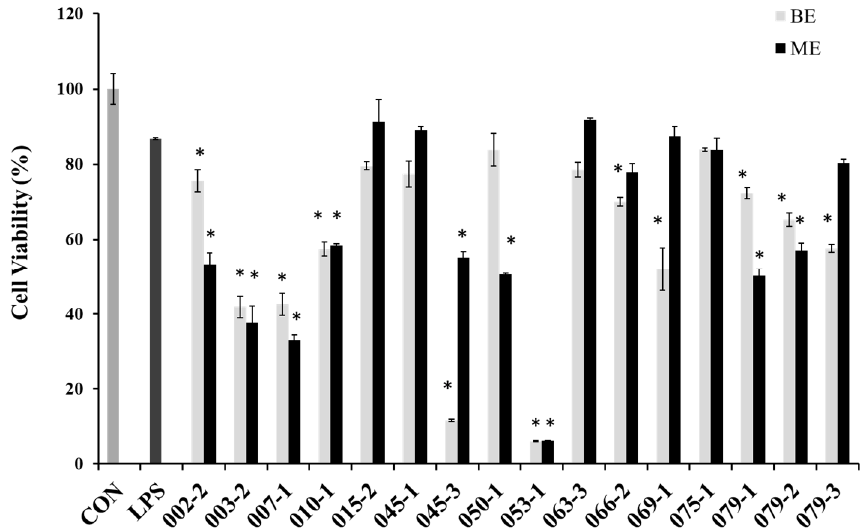
Figure 1. Cell viability of the extracts from marine-derived fungi in RAW 264.7 macrophages. Experiments were performed in triplicate and the data are expressed as mean ± SE. BE and ME represent the broth and mycelium extract obtained from each of the cultured fungus. * p < 0.05 indicates significant differences from the LPS-stimulated group.